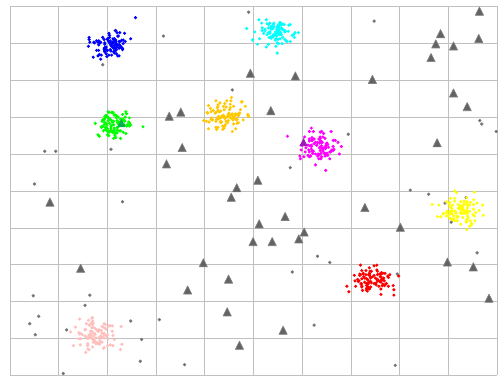
Figure 3. Visualization of a synthetic generated D2K8 dataset used in this work. Ground truth clusters are each represented by a separate color. Gray nodes are noise nodes. Gray triangles represent noise nodes detected by the NBR–Clust algorithm. Equivalent colors match corresponding clusters in Figure 4.